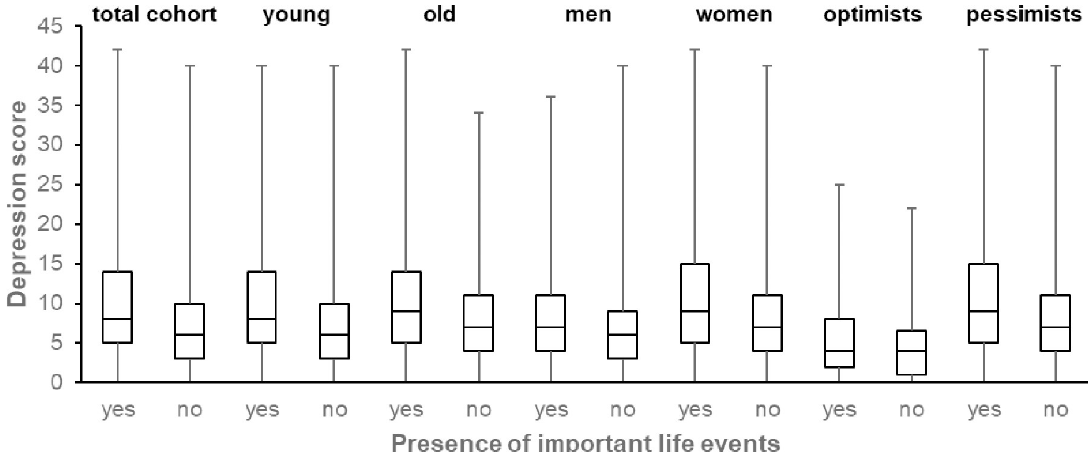
Fig 2. Box and whisker plots demonstrating Center for Epidemiological Studies Depression Scale (CES-D) depression score for presence and absence of important life events in the total cohort and stratified by age (young � 65 years vs old > 65 years), sex (men vs women), and optimism (optimists Life Orientation Test-Revised (LOT-R) score > 18 vs pessimists LOT-R score � 18). The horizontal line in each box represents the median with the box representing the interquartile range (Q3-Q1) and the whiskers representing the total range of the data (max-min).